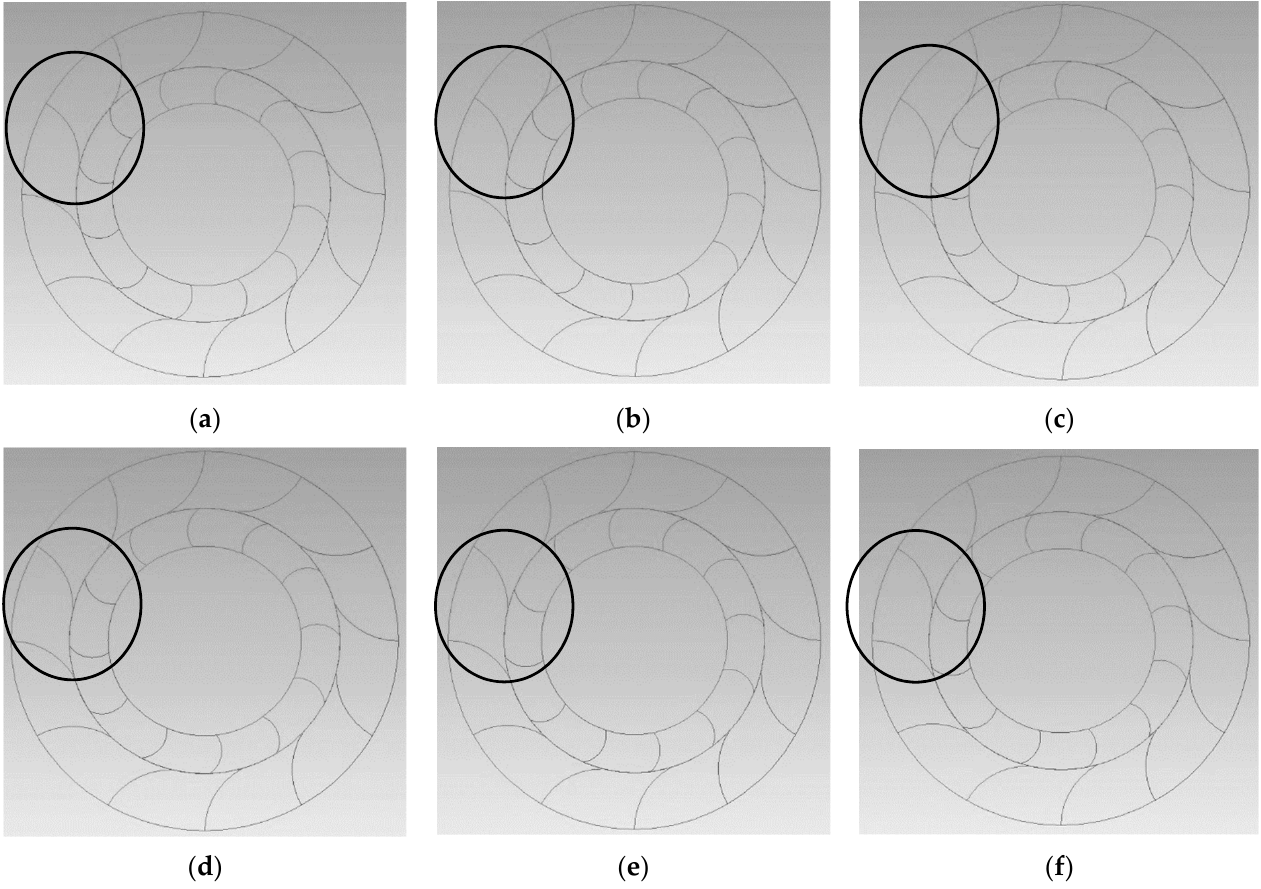
Figure 7. Positions of rotor blades w.r.t. stator blades: ( a ) 0° (in-line; same as 30°), ( b ) 5°, ( c ) 10°, ( d ) 15°, ( e ) 20°, ( f ) 25°.